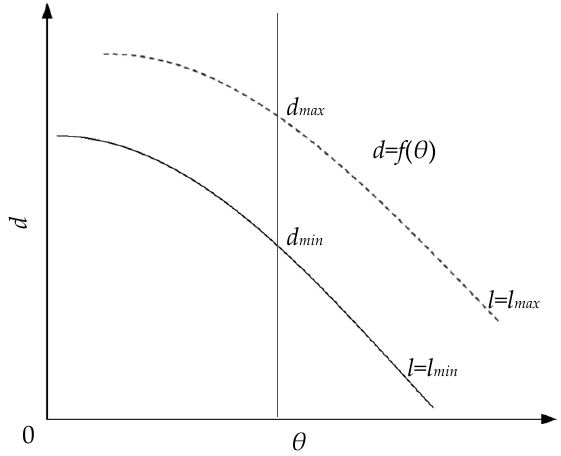
Figure 7. The relationship between the thickness d and the angle θ .